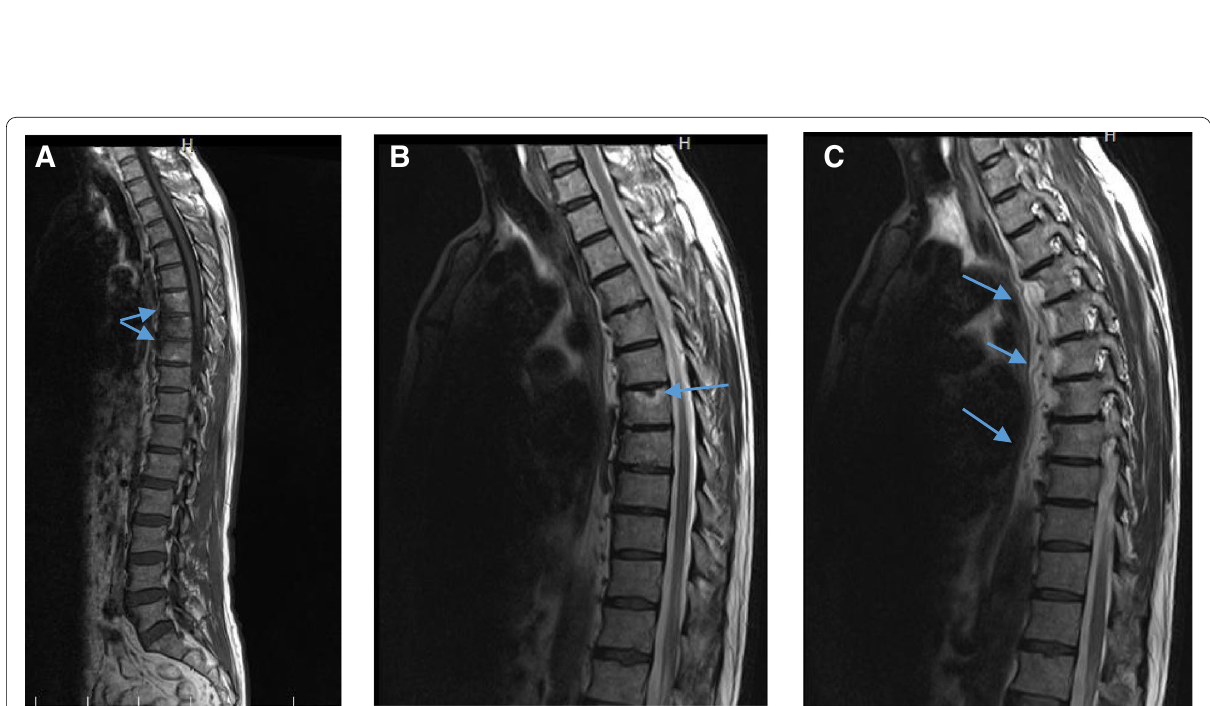
Fig. 6 T1- and T2-weighted sagittal spinal MRI. T2-weighted sagittal MRI reveals bone marrow edema (osteitis) of 7th and 8th thoracic vertebrae in parallel with bone scan findings ( A ). T1-weighted MRI showing cortical erosion with surrounding edema in 7th thoracic spinal vertebra ( B ). Flowing thick osteophytes along anterior border of thoracic vertebrae without intervertebral disk involvement consistent with DISH ( C ). MRI, magnetic resonance imaging; DISH, diffuse idiopathic skeletal hyperostosis. All radiographic images were screenshotted from the compact